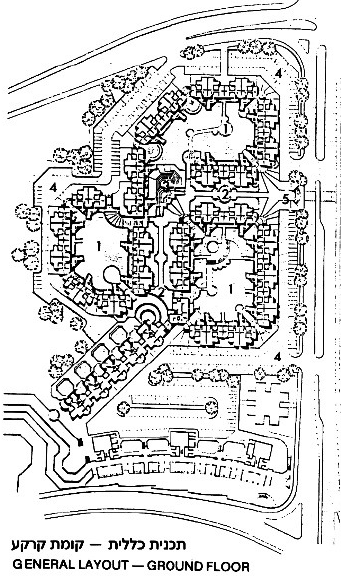
Figure 5. Complex planned by Salo Figure 6. Overview of the complex planned by Salo Harshman in Gilo, East Harshman in Gilo, East Jerusalem. Jerusalem. This design means that the tenants see each other and the inner green General layout: Ground floor. area from their apartment windows. Source: Harlap (1988, p. Source: Harlap (1988, p. 113).